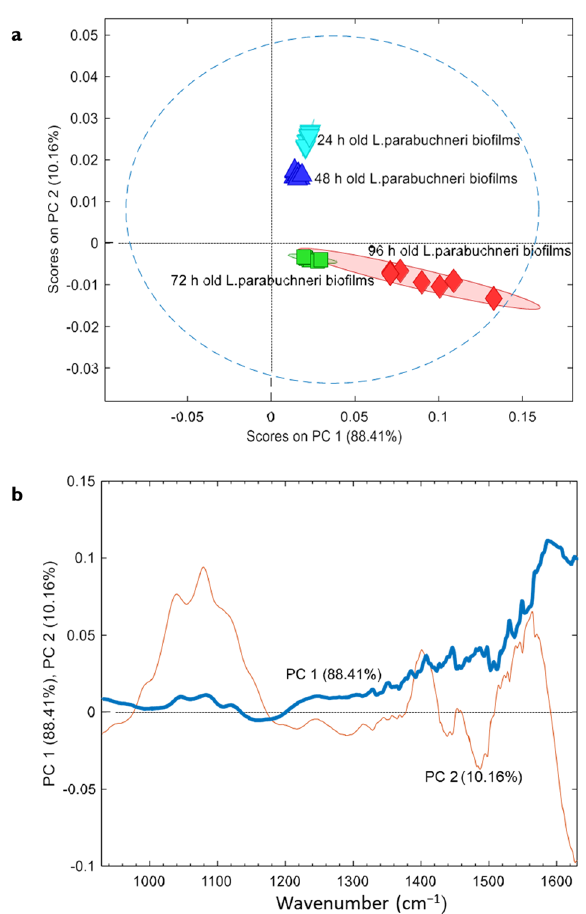
Fig. 9 Multivariate classi fi cations of IR spectral datasets of L. parabuchneri bio fi lms via principal component analysis. a Scores plot of the classi fi ed spectral data recorded after 24, 48, 72, and 96 h via PCA revealing that the obtained spectra clearly cluster along the time axis and that the recorded IR spectra unambiguously identify the maturation stage of the bio fi lm; b loadings of the two PCs explaining >98% of the total